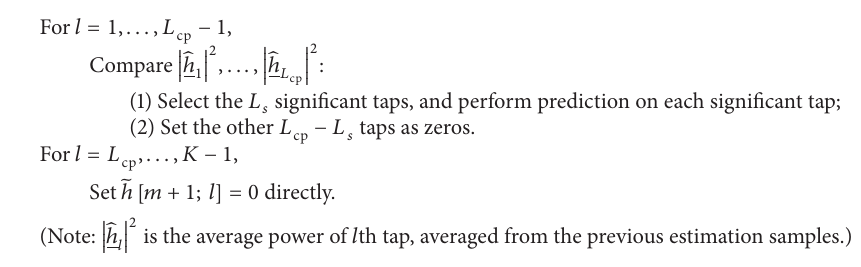
Algorithm 1: Tap selection